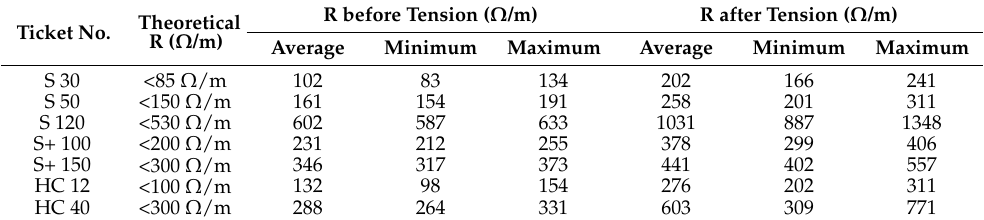
Table 5. Resistance measurements per thread, pre- and post-permanent deformation